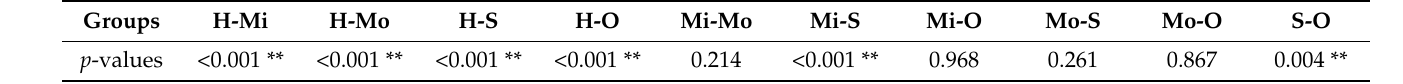
Figure 3. LWC variation trend of moso bamboo leaf under different damage states. Table 2. ANOVA analysis of LWC of moso bamboo leaves under different damage